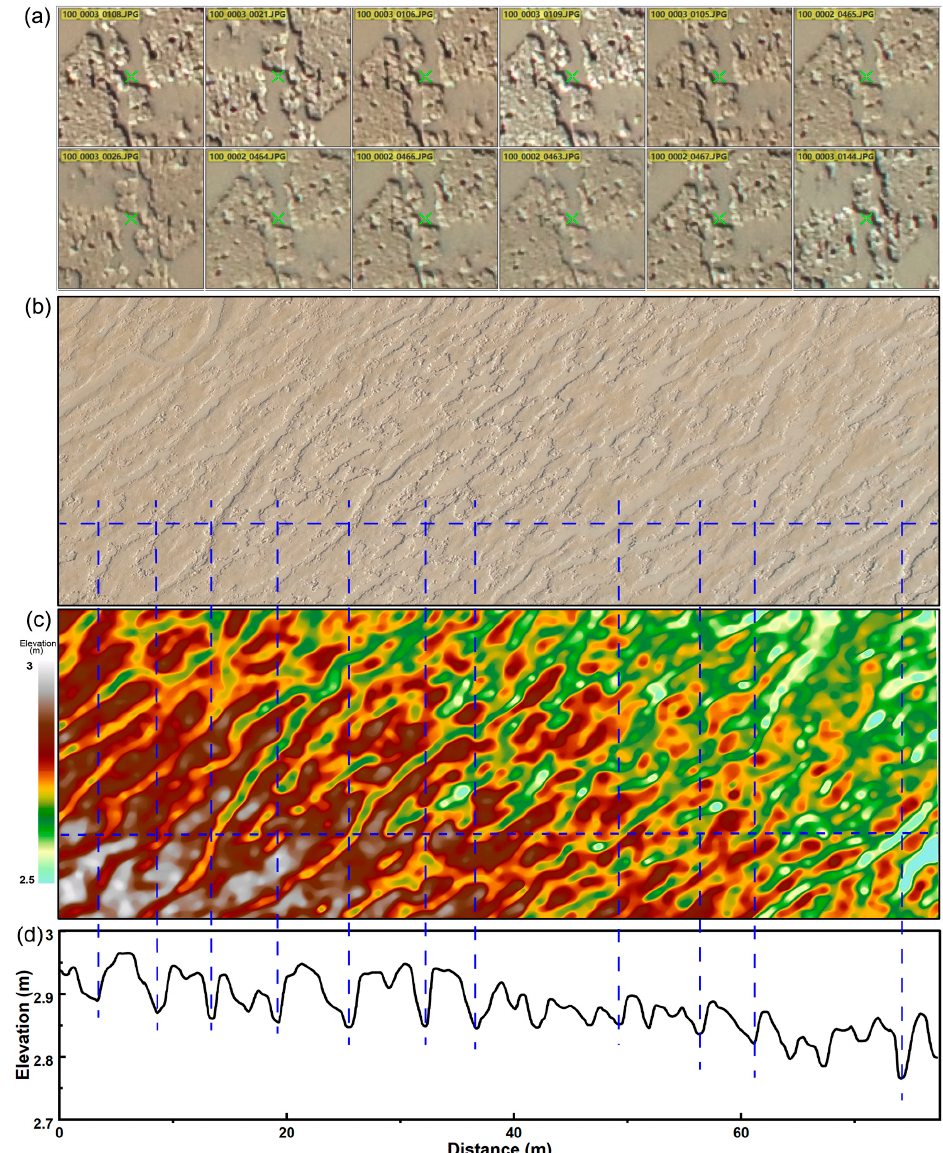
Figure 6. ( a ) The detection and matching of image key points in water-bearing areas; ( b ) the UAV- based orthomosaic; ( c ) the UAV-based DEM; and ( d ) elevations along one profile. When overlaying the identified water pixel boundaries with the orthophotos and DEMs obtained by P4R revealed that the elevation of the area where the water pixels are located is lower (Figure 7b), which is consistent with reality. It was also found that the water surface elevation values in the same area varied within approximately 2 cm, and no significant elevation anomalies were found due to the presence of the water surface. By comparing the elevation values of water pixels with their adjacent non-water pixels, it was found that 99% of the non-water pixels had an elevation greater than that of their adjacent water pixels, with an average bias of 4.6 cm (Figure 7c). In addition, field measurements of the height of the water surface from the non-water surface and the thickness of the water-bearing layer along the water boundary revealed that the height of the water sur- face from the non-water surface was approximately 5 cm and the thickness of the water layer was approximately 2 cm (Figure 7d). This suggested that the elevation generated by